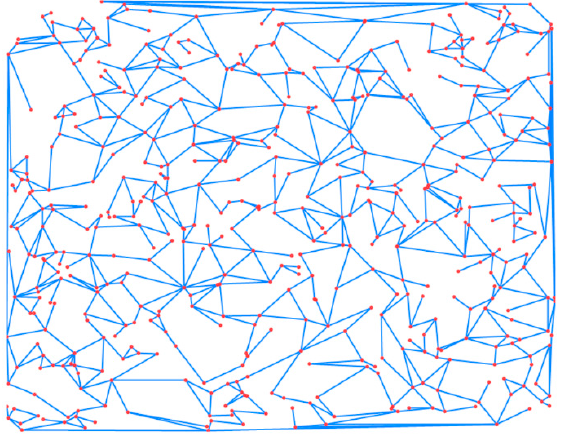
Figure 4. Example of an accidental planar network consisting of 500 junctions with an average number of links equal to 2.9.